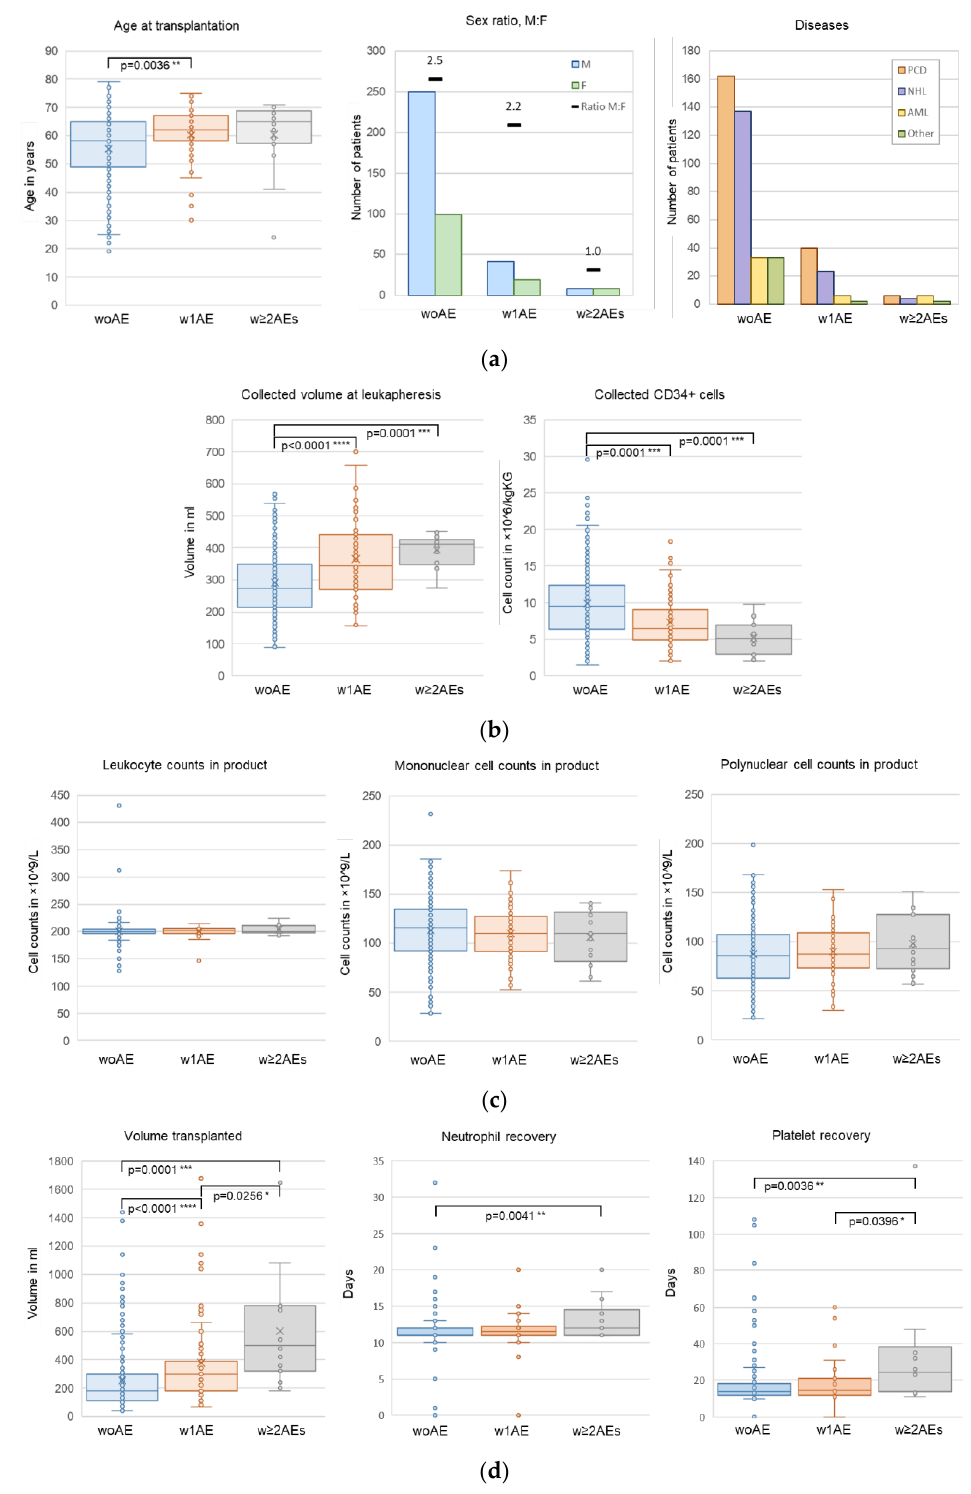
Figure 4. Parameters according to number of AEs. ( a ) Age, sex, and disease (all data included), ( b ) collected volumes and CD34+ cells during leukapheresis, ( c ) numbers of Lc, MNC, and PNC in the transplant product, ( d ) total transplanted volumes and times to reach an absolute neutrophil count of 0.5 × 10 9 /L and a platelet count of >20 × 10 9 /L. Data without the CD34+-selected